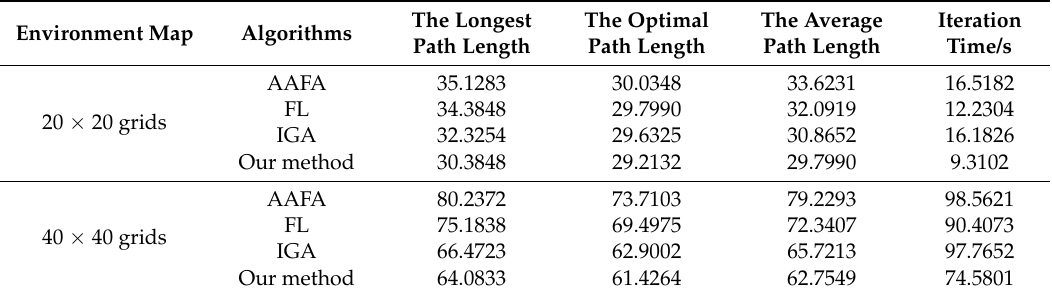
Table 1. Performance comparison of four algorithms.